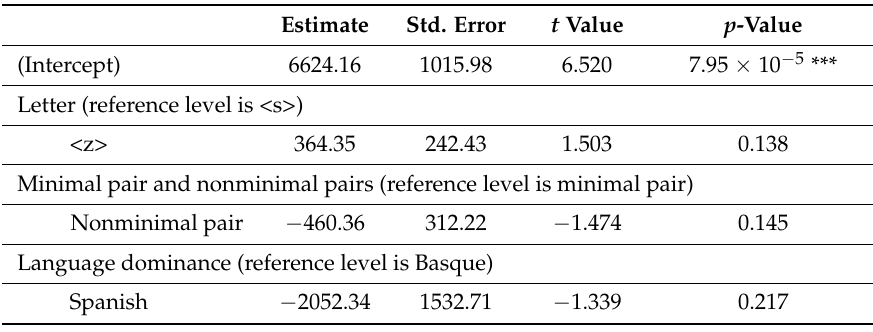
Table 7. Estimate, standard error, t value, and p -value of the best fit model in the mixed-effects regression